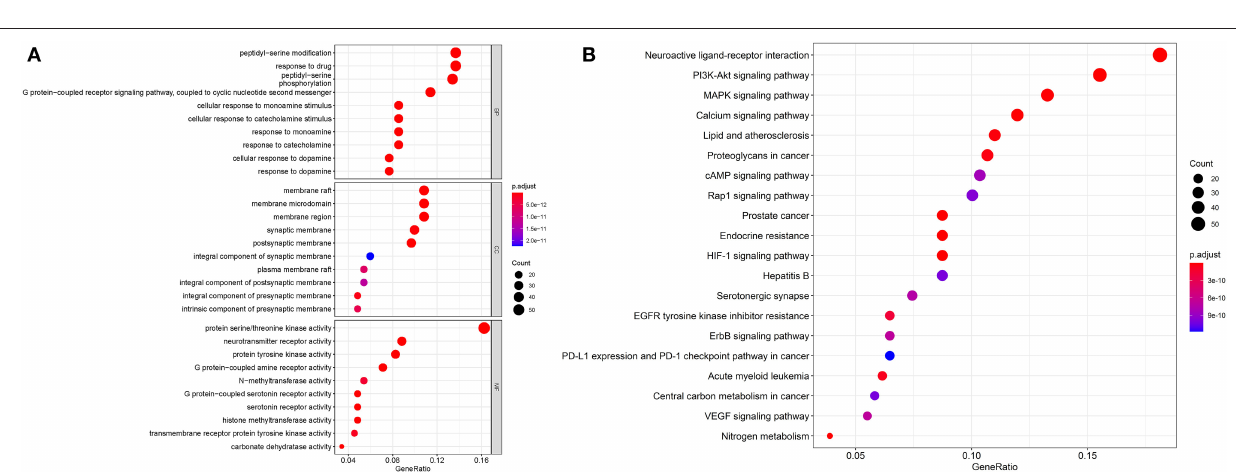
geographical differences between the Tibetan region and the non–Tibetan